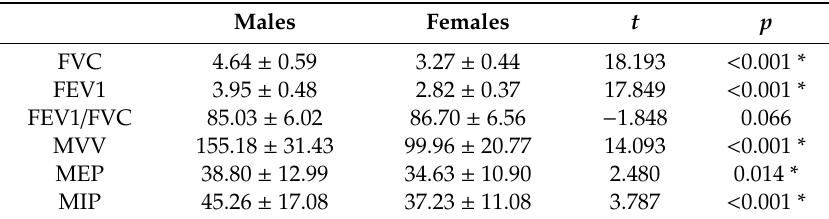
Table 4. Analysis of lung function variables by gender.